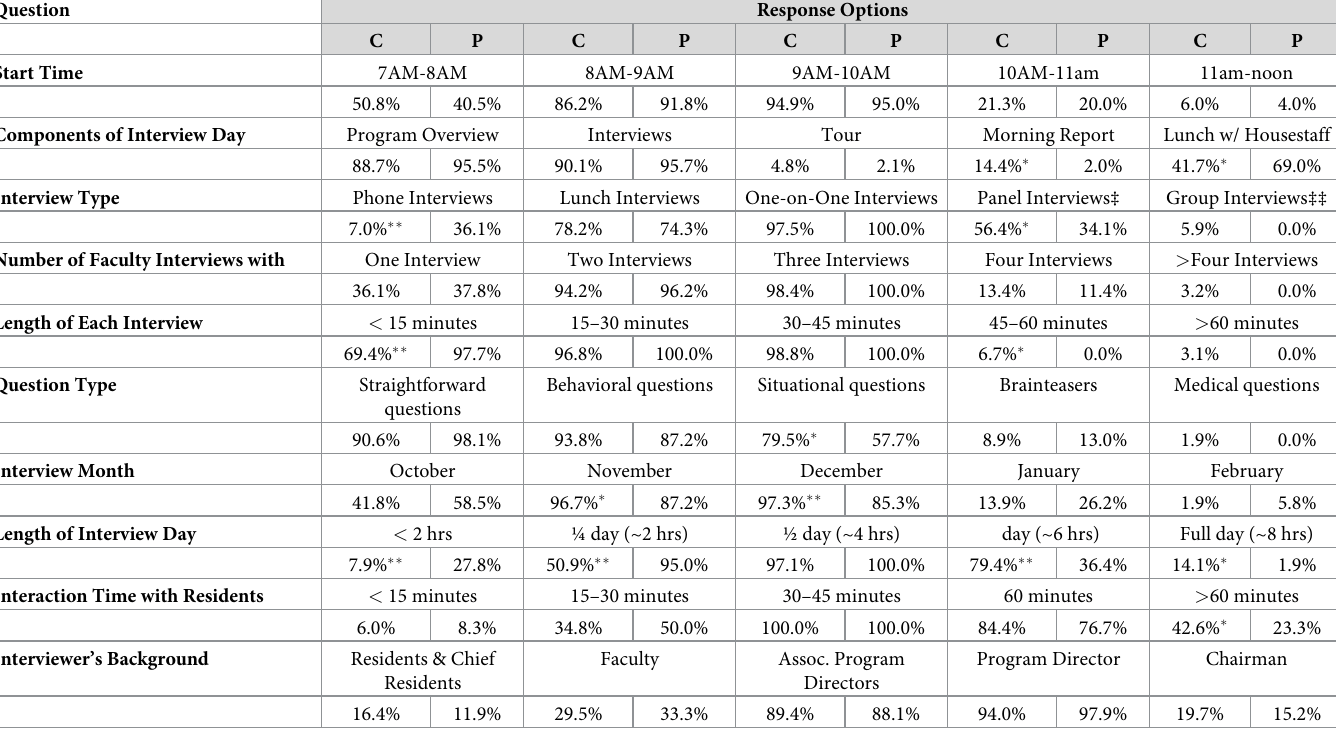
Table 1. Preference for categorical (US +IMG) versus preliminary